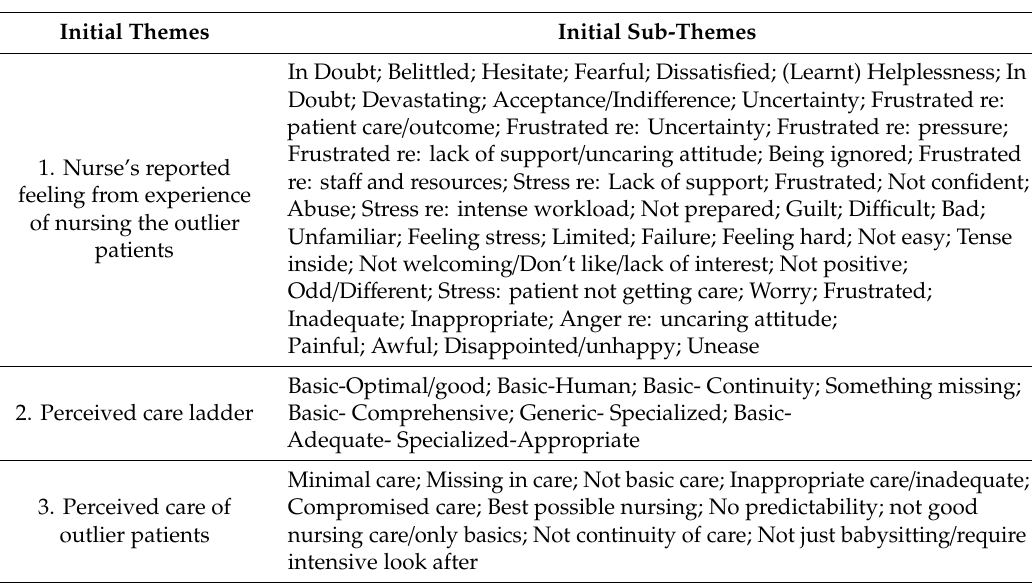
Table 3. Conducting initial thematic